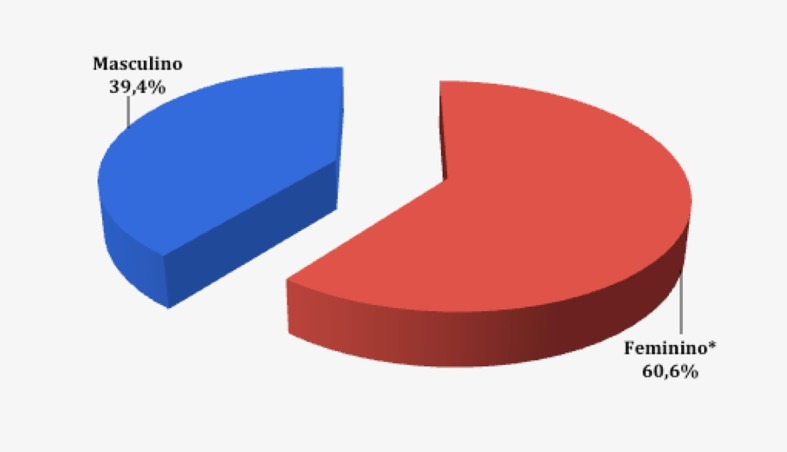
Distribuição da amostra quanto ao gênero. *p < 0,05.